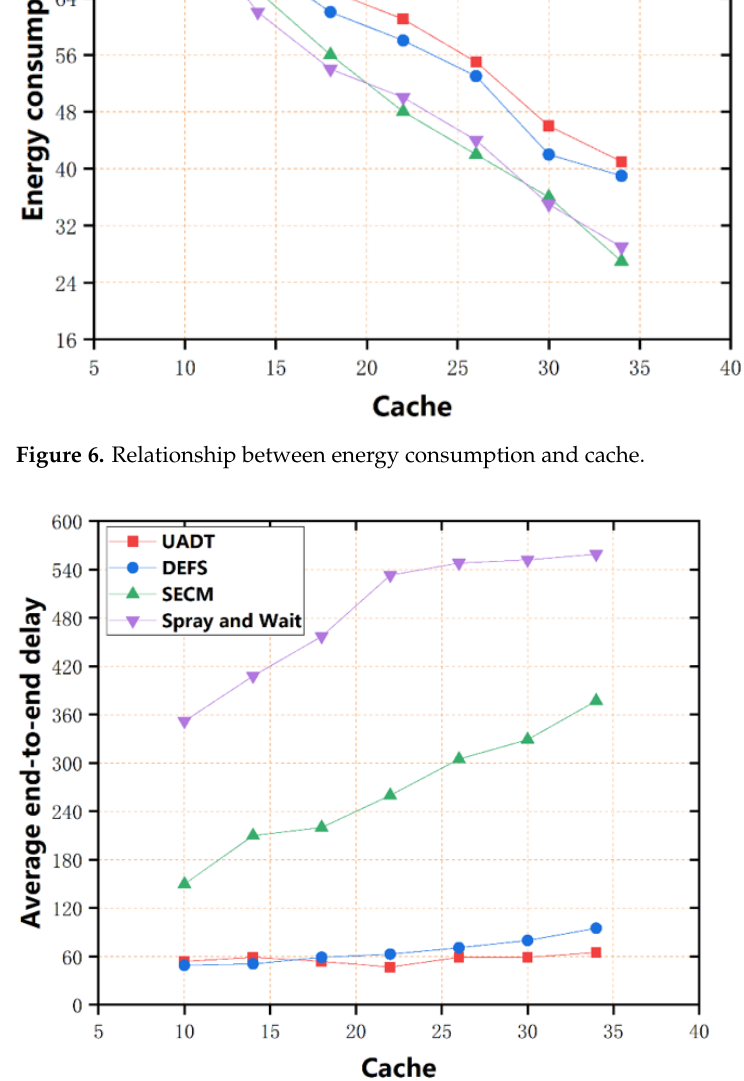
Figure 7. Relationship between average end-to-end delay and cache.